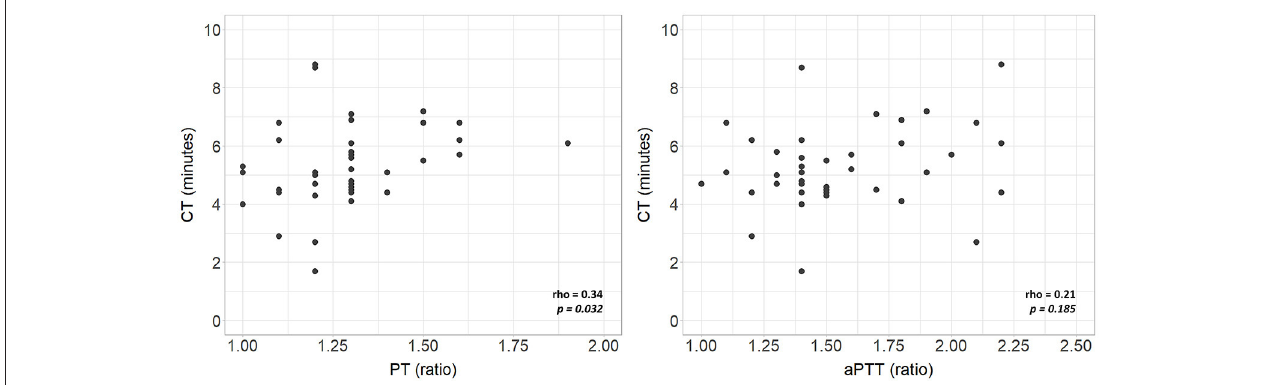
FIGURE 3 | Scatterplots of VCM parameters and corresponding laboratory coagulation parameters: PT and aPTT. rho, Spearman’s correlation coefficient; p, p-value; PT, prothrombin time; aPTT, activated partial thromboplastin time.